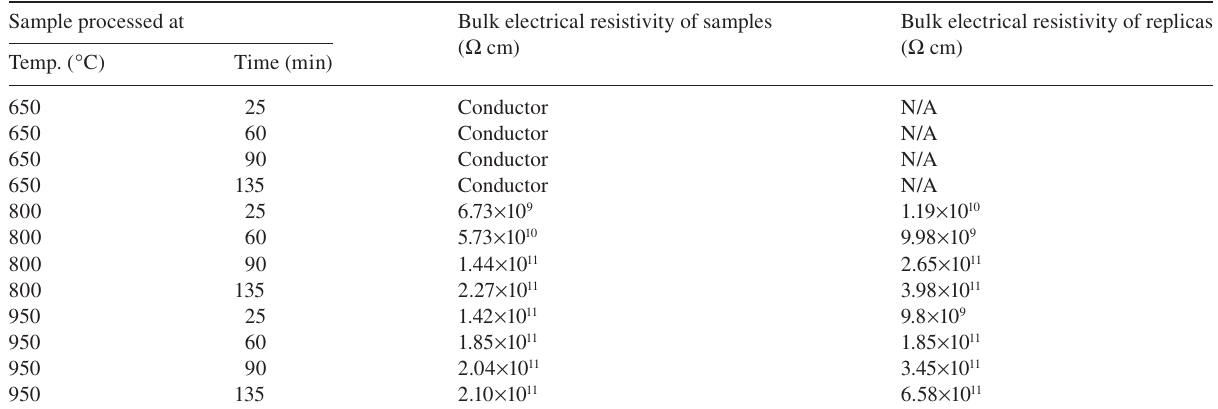
Table 3 Electrical resistance measurements.